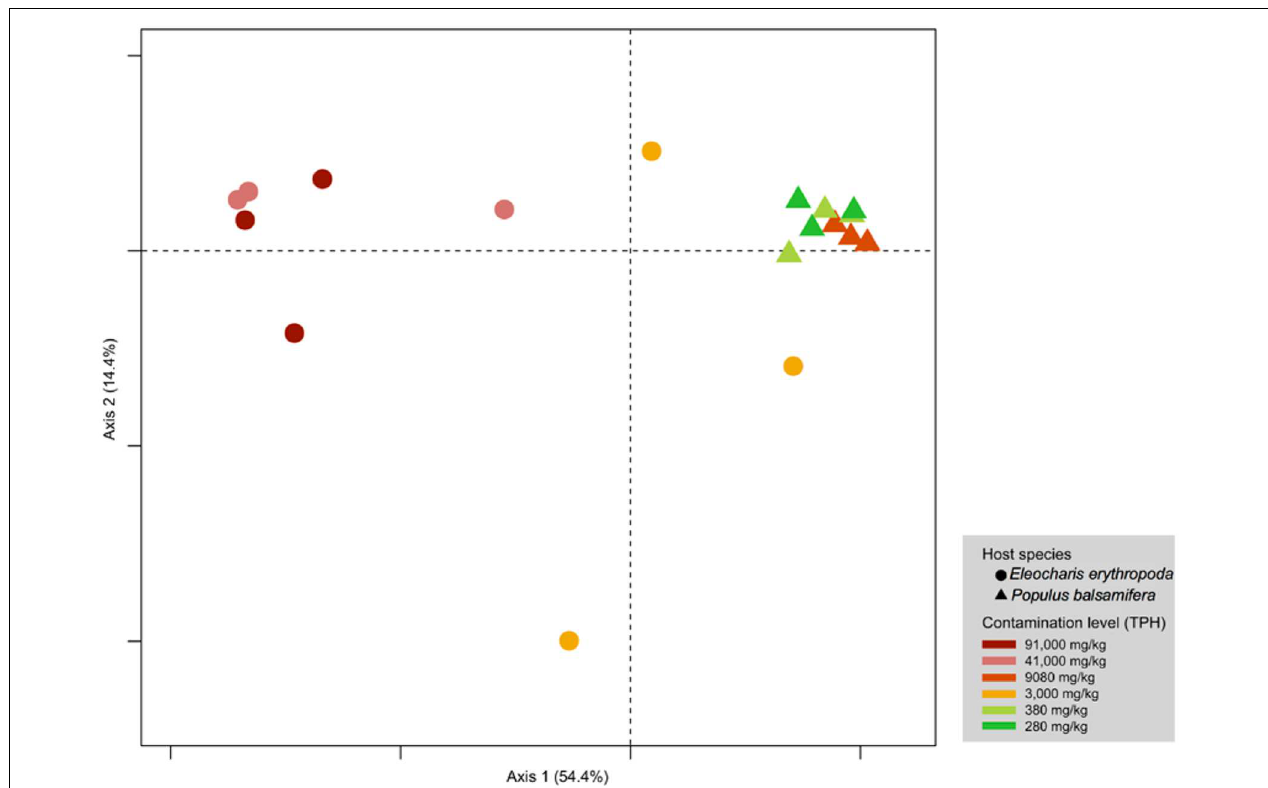
FIGURE 2 | Principal coordinate analysis of fungal endophytes of E. erythropoda and P. balsamifera roots. The fungal communities were binned at phylotype resolution and were ordinated using PCoA based on Hellinger distance. Individual samples were colored based on the level of petroleum hydrocarbon contamination.